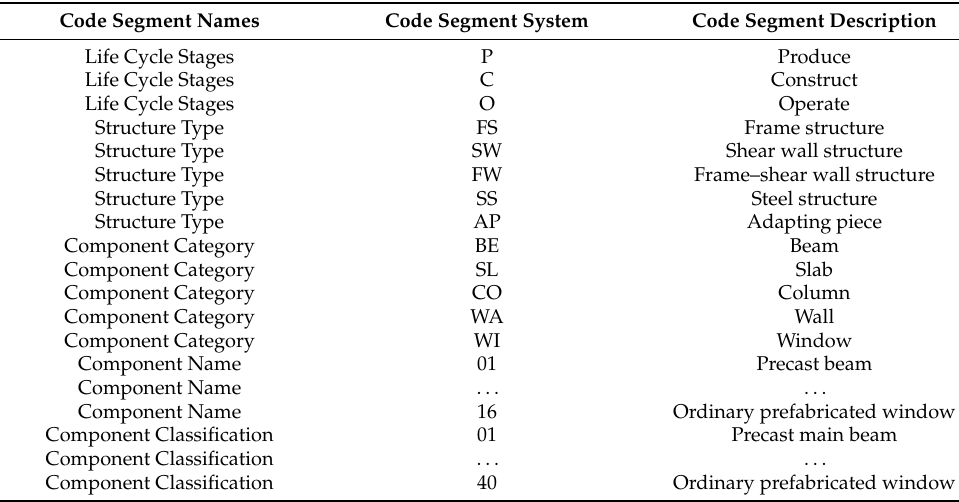
Table 2. Table of significance of prefabricated component code